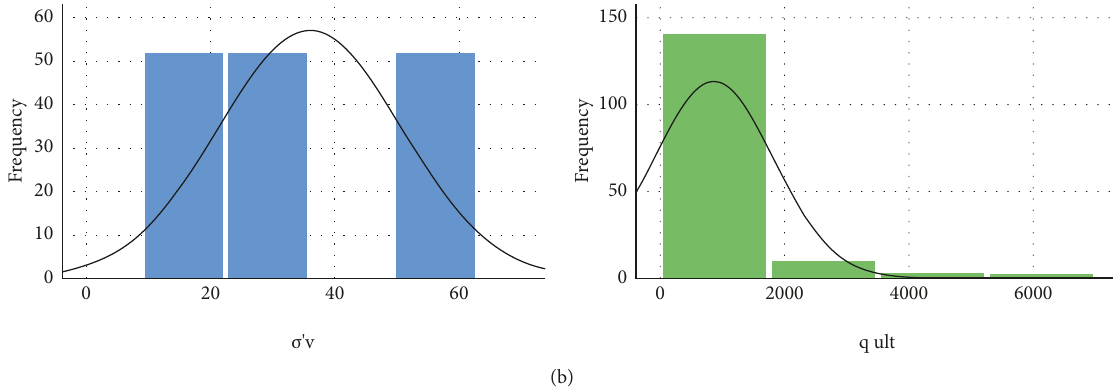
Figure 3: Distribution histograms for inputs (in blue) and outputs (in green).